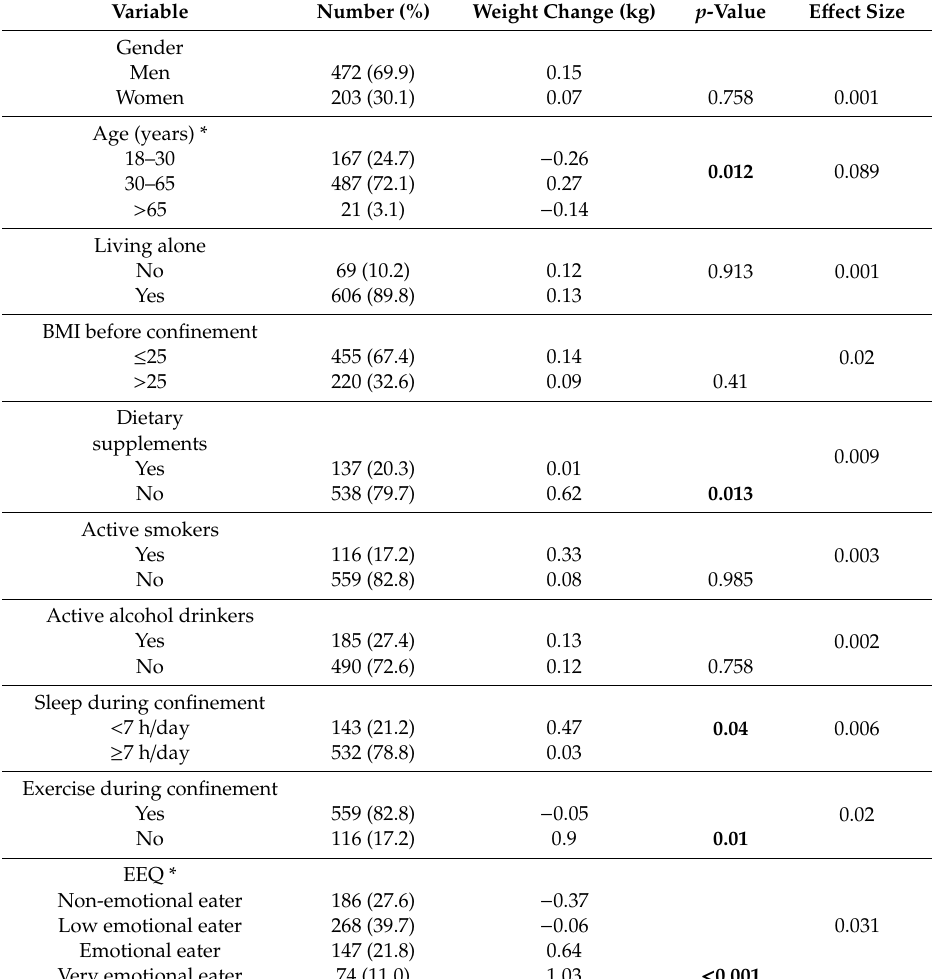
Table 4. Changes in weight during confinement according to di ff erent